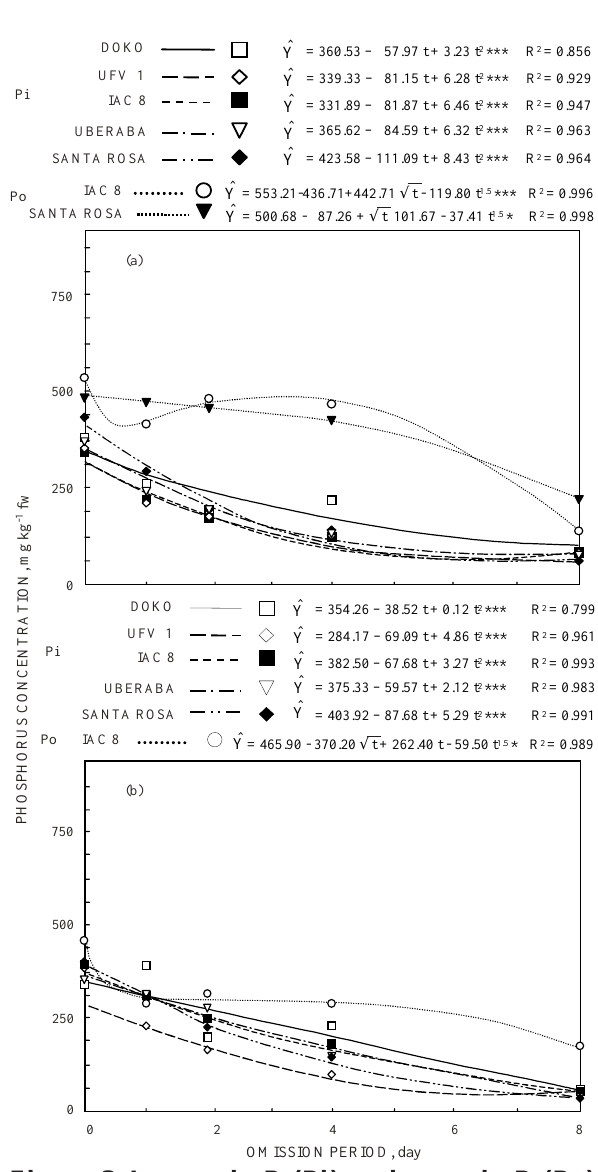
Figure 3. Inorganic P (Pi) and organic P (Po) concentration in fresh matter of the lower leaves (a) and stems (b) of five soybean cultivars as a function of the P omission period. (*, ***: Significant at 10 and 1 %, respectively).